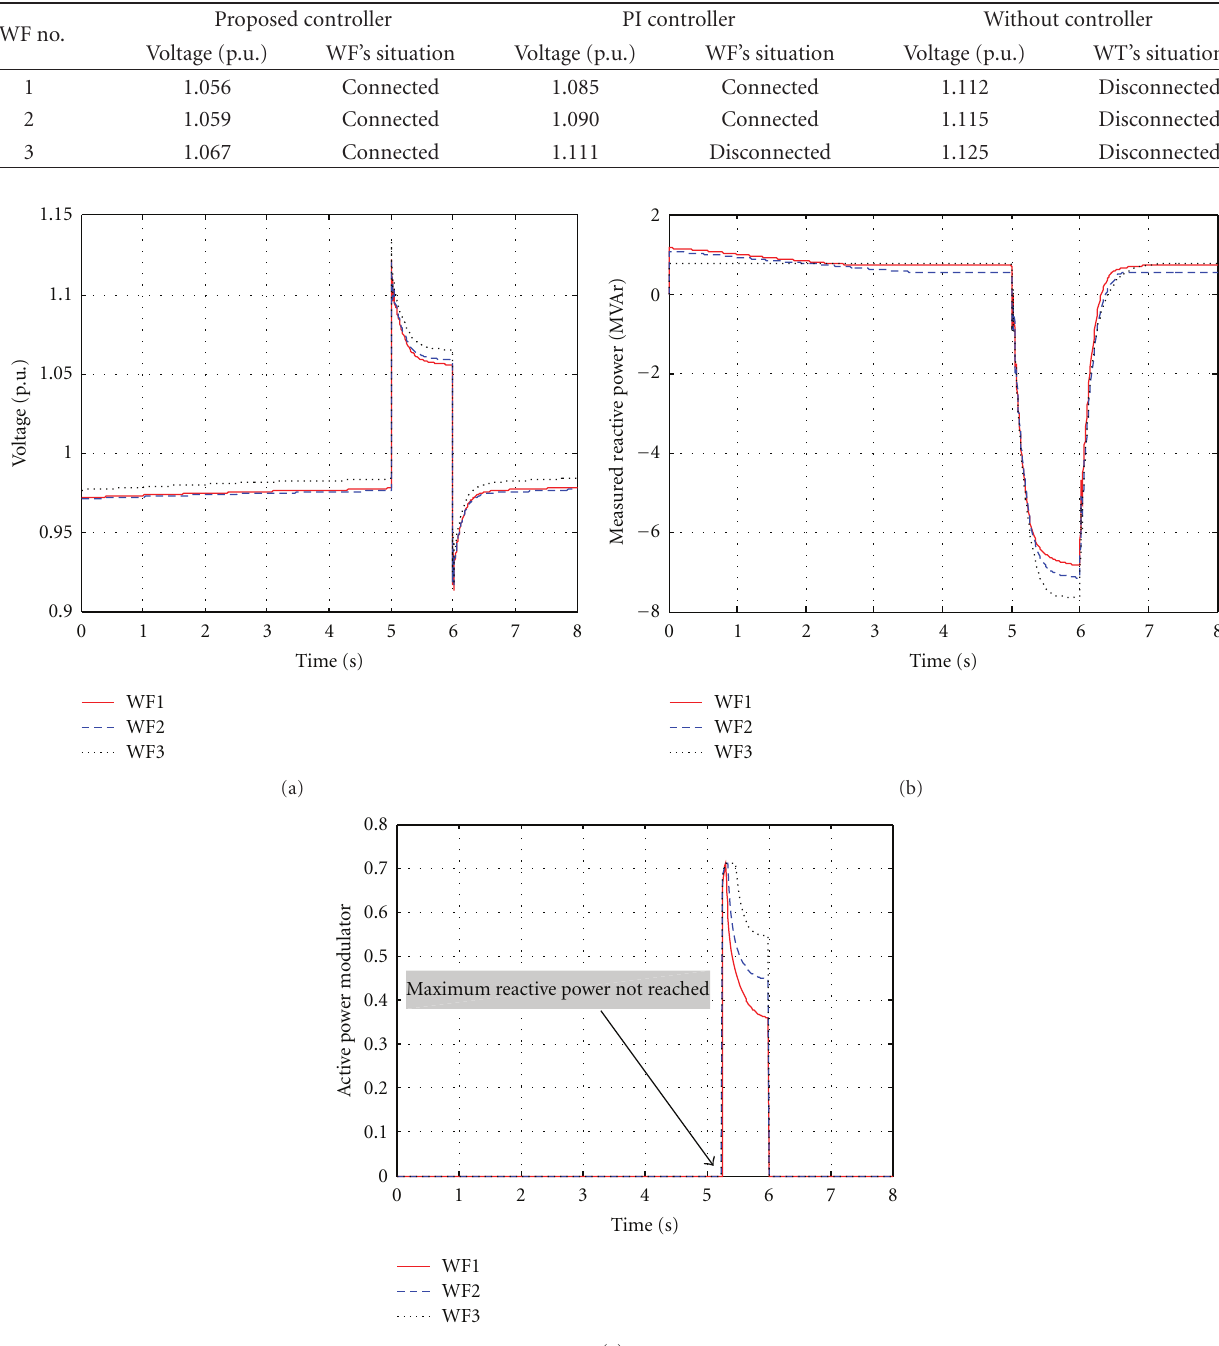
Figure 8: (a) Voltage, (b) measured reactive power, and (c) active power modulator at the